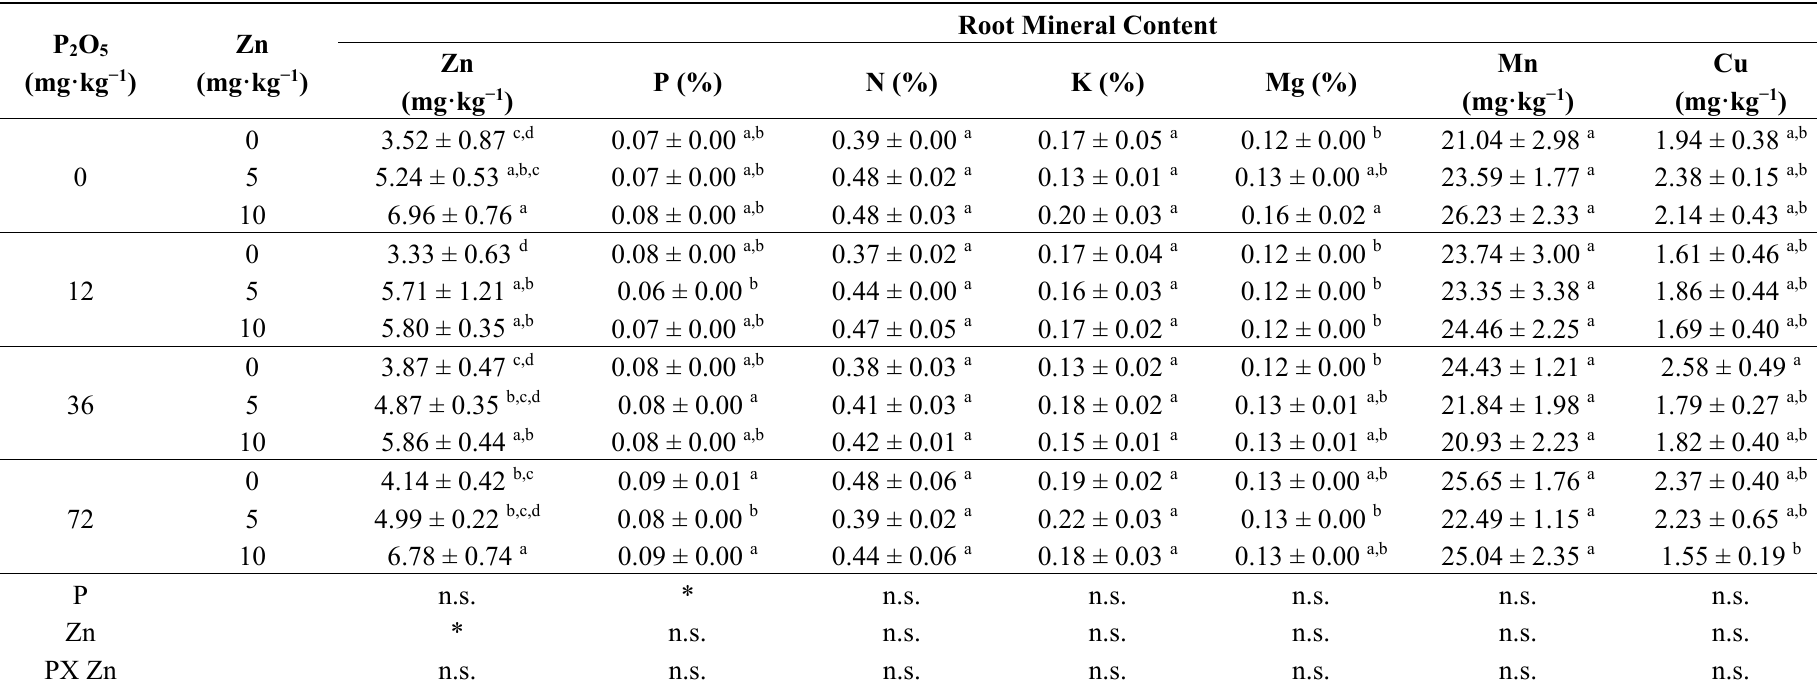
Table 6. Effect of zinc and phosphorus supply on root mineral content of corn silage at